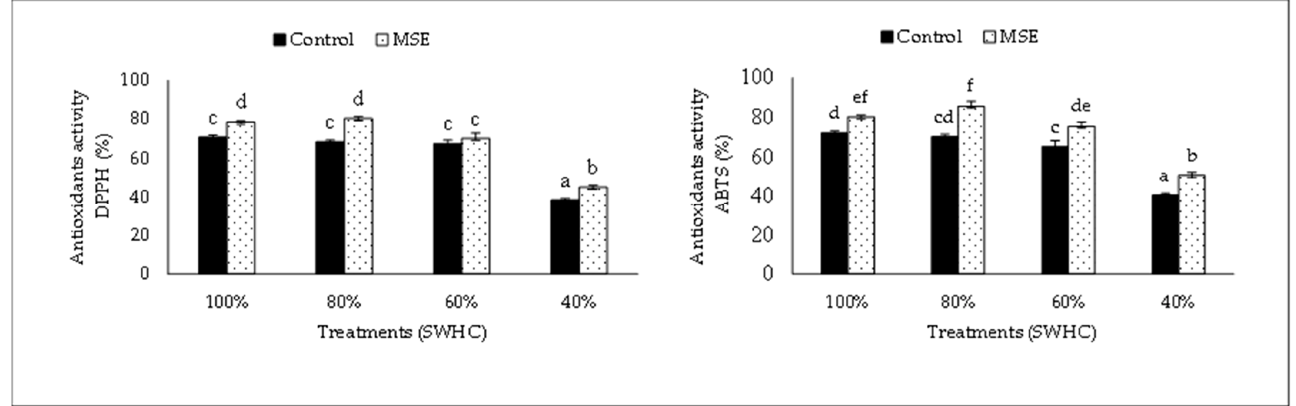
Figure 2. Antioxidants activity (DPPH and ABTS) of cancer bush ( S. frutescens ) plants treated with moringa ( M. oleifera ) seed extract (MSE) under deficit irrigation conditions. SWHC = soil water holding capacity; DPPH = 2 ′ -Diphenyl-1-picrylhydrazyl; ABTS = 2,2 ′ -azinobis-3-ethylbenzothiazoline-6-sulfonic acid. Vertical bars represent standard error (SE) of the mean value ( n = 3). Means followed by different letters in each bar indicate a statistically significant difference ( p < 0.001).